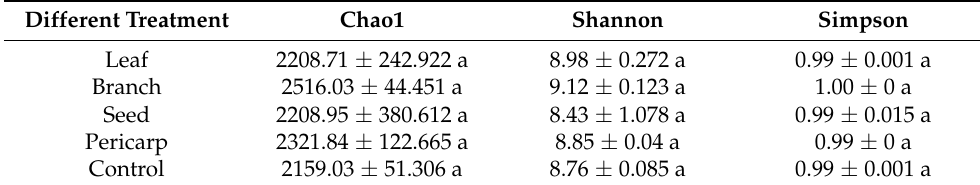
Table 1. Soil microbial α -diversities among the different treatments.